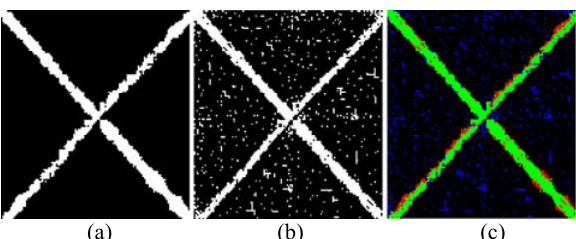
Figure 6. Results of exhaustive pairwise matching, the proposed method and their difference graph